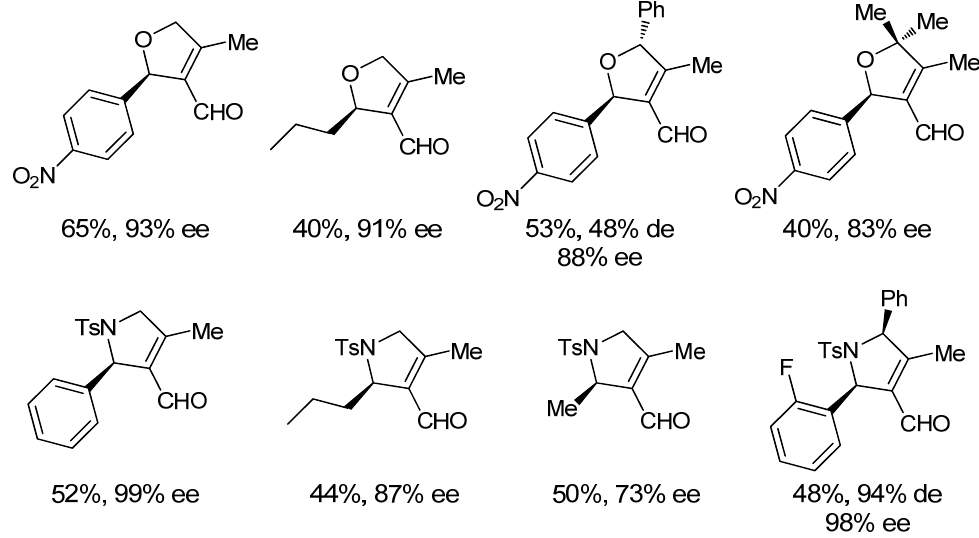
Figure 6. Representative examples of chiral dihydrofurans and pyrrolines prepared by amine- and palladium-catalyzed enantioselective